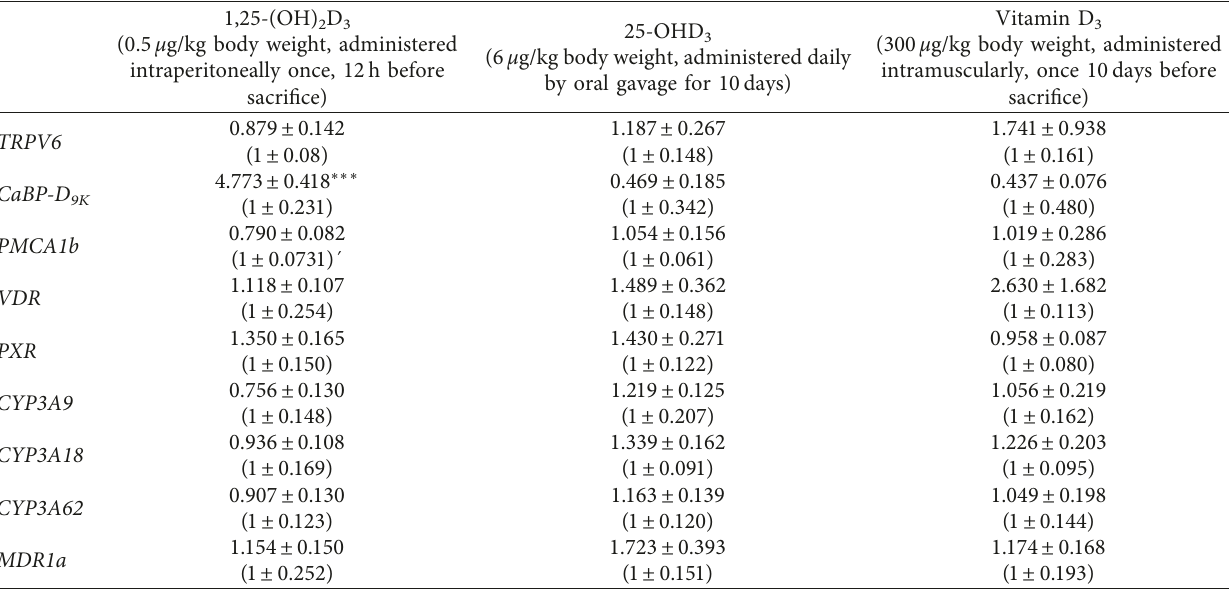
Table 3: RNA expression in the proximal jejunum of rats treated with different vitamin D metabolites normalized to GAPDH.